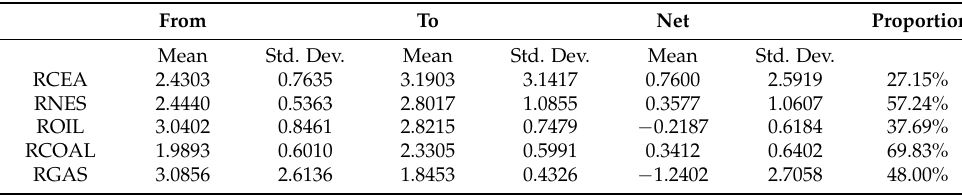
Table 6. Summary statistics of dynamic connectedness.